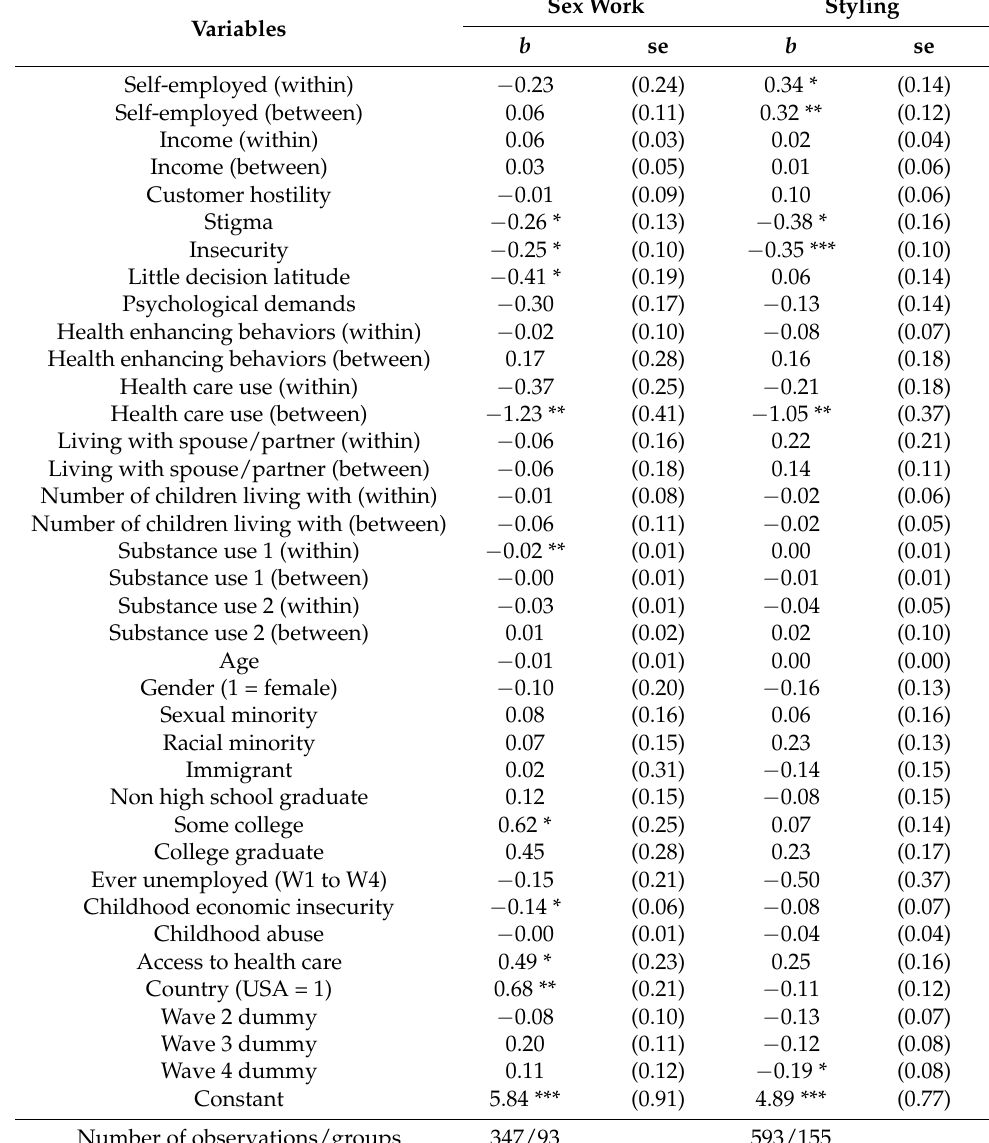
Table 3. Mixed Effects Multivariable Regression, Overall Mental Health and Job